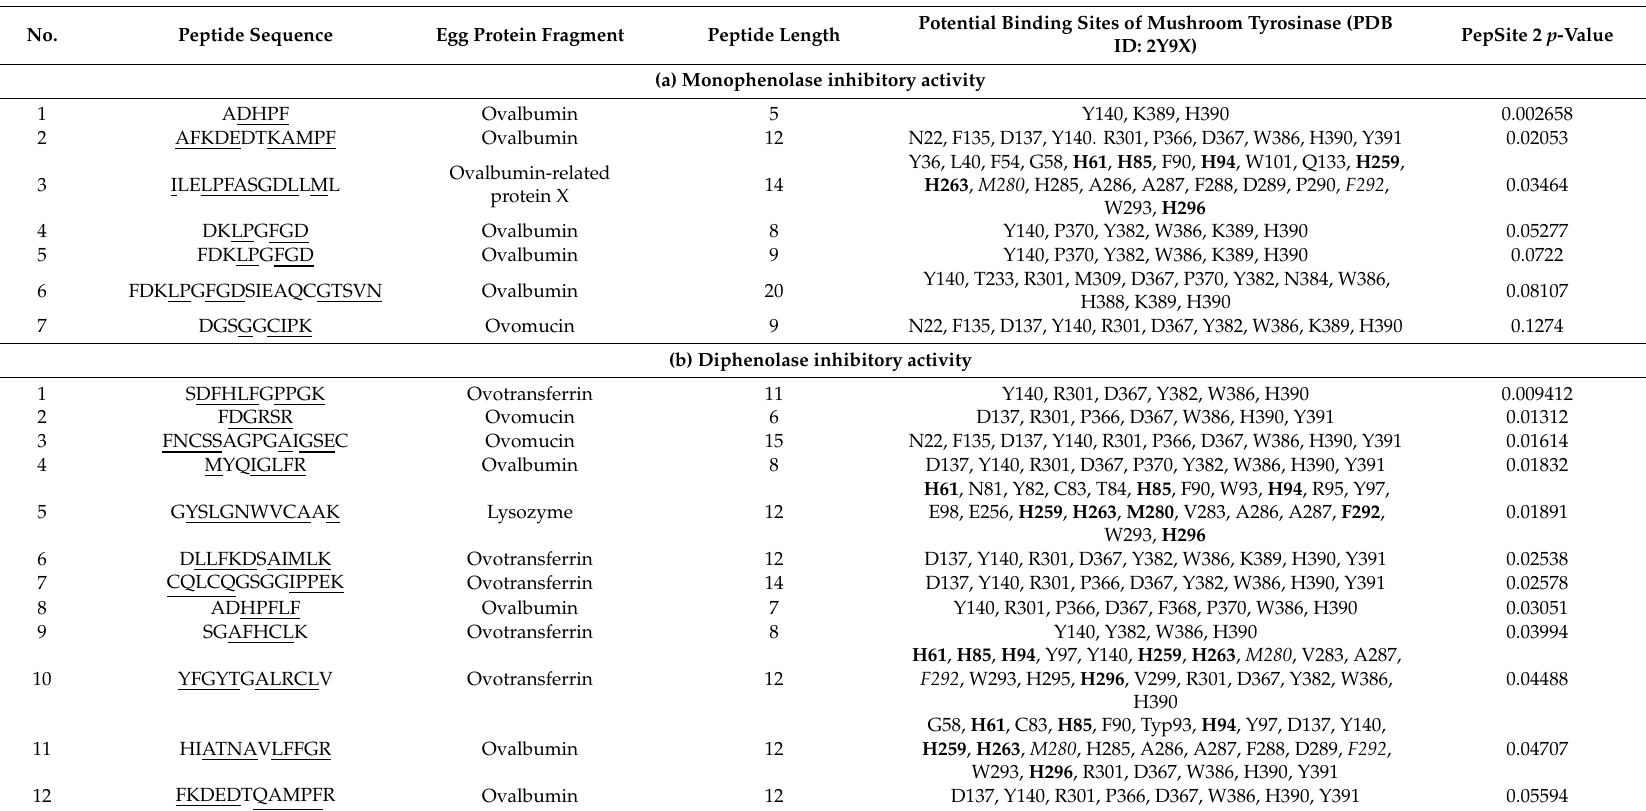
Table 4. List of potential biologically active egg white-derived peptides shortlisted for ( a ) monophenolase and ( b ) diphenolase inhibitory activities using PeptideRanker web server and their potential binding sites on mushroom tyrosinase predicted using PepSite 2 web server.